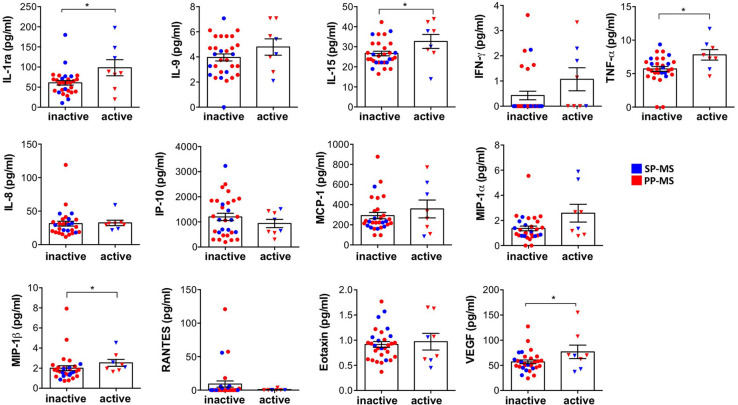
The differential expression of immune soluble factors released in the CSF of patients with progressive MS in active and inactive diseases. The levels of IL-1ra, IL-9, IL-15, IFN-γ, TNF-α, IL-8, IP-10, MCP-1, MIP-1α, MIP-1β, RANTES, eotaxin, and VEGF were measured, by multiplex assay, in the CSF of subjects with progressive MS distinct by the absence (inactive) or the presence (active) of gadolinium detection on MRI. Each CSF sample was analyzed in duplicate and means are represented. Mann–Whitney U-test was used to compare different conditions. Data are reported as mean ± SEM. *p < 0.05.